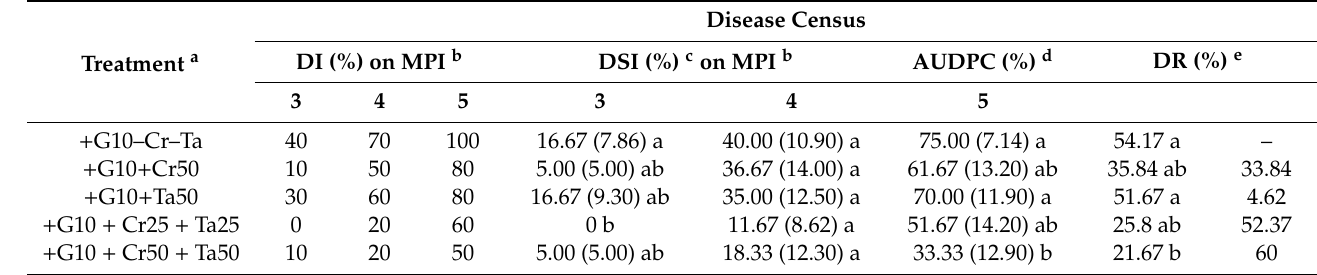
Table 3. E ff ects of Ta and Cr, either applied individually or in combination on the development of oil palm BSR by Ganoderma boninense.